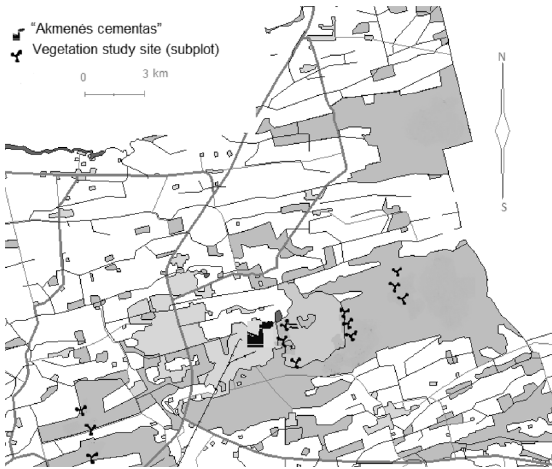
Fig. 1. Location of study sites in vicinity of “Akmenės cemen- tas” and in control forest stands